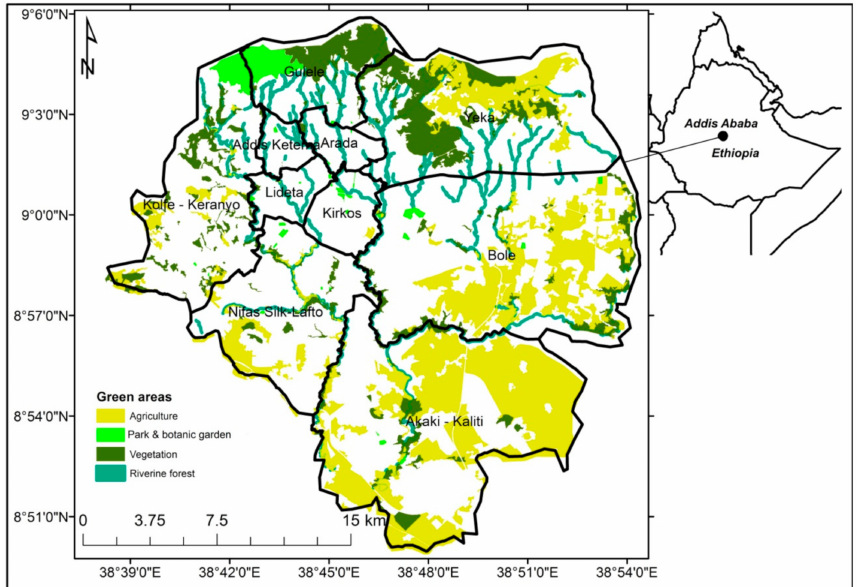
Figure 1. Map of Addis Ababa showing the 10 sub-cities and distribution of green